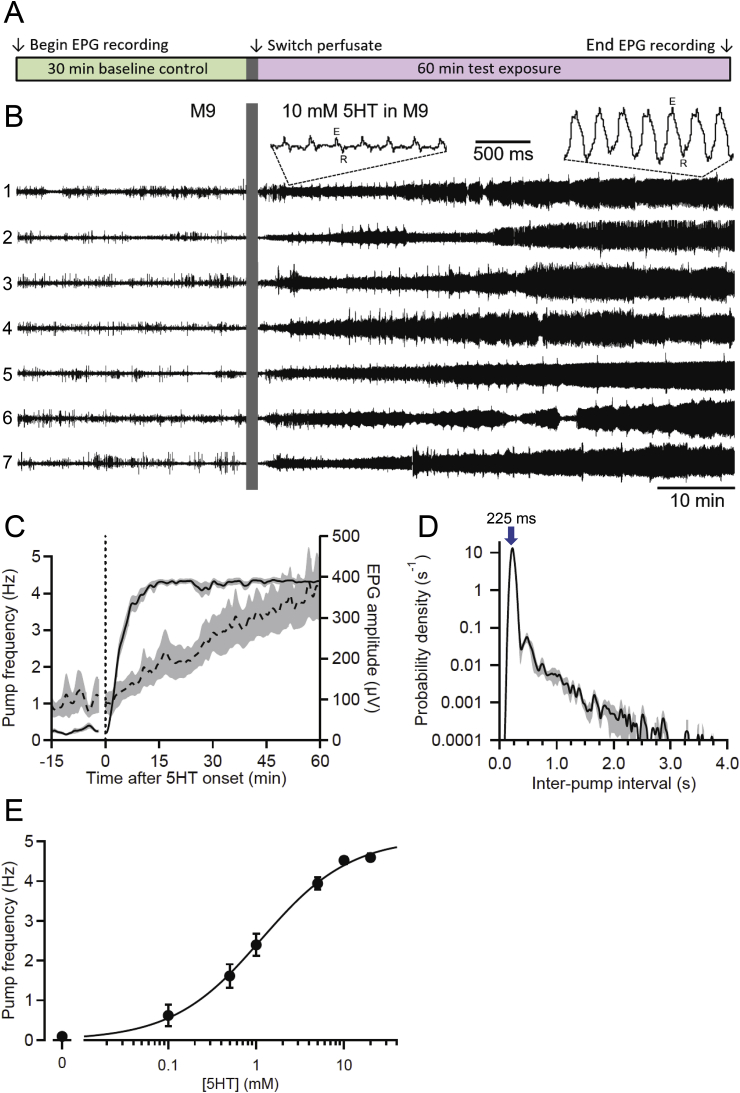
Stimulation of pharyngeal pumping by 5HT. A. Experimental protocol for most experiments. Worms were perfused with a control solution for 30 min, followed by switching the perfusate to a test solution and recording for 60 min more. B. Representative example of 5HT-stimulated EPG activity. Simultaneous EPG recordings from seven N2 worms (numbered 1 to 7) in one chip: each trace from a different worm. Baseline pumping in M9 was followed by switching (vertical bar masks electrical artifact) to 10 mM 5HT in M9. Pumping increased rapidly and EPG amplitude increased over time (insets show pumps from worm 1; E, excitatory spike, R, relaxation spike). Worms 1, 5 and 6 were head-first in worm traps while the others were tail-first. C. Effect of 5HT on pump frequency and amplitude. Switch to 10 mM 5HT occurred at the vertical dotted line, with the electrical artifact blanked. Time-series data were extracted using custom software (see Section 2.6) and plotted as mean pump frequency (solid line) and amplitude (dashed line; peak-to-peak from E spike to R spike) (shading depicts S.E.M. in all Figures; n = 19 worms). D. IPI probability density histogram for worms in 10 mM 5HT, during t = 30–60 min post-switch (same worms as C). The mode of the distribution is marked (arrow; 225 ms, or 4.44 Hz). E. Steady-state pump frequency increased with 5HT concentration. Worms were perfused for 60 min with 5HT to achieve steady-state pump frequency, which was measured for the next 30 min (t = 60–90 min). Plot shows mean ± S.E.M. (n = 19–23 worms/group) pump frequency for different 5HT concentrations, fitted using the Hill equation (maximum frequency, 5.08 Hz; C1/2, 1.15 mM; Hill coefficient, 0.86). Some error bars are smaller than the symbols.